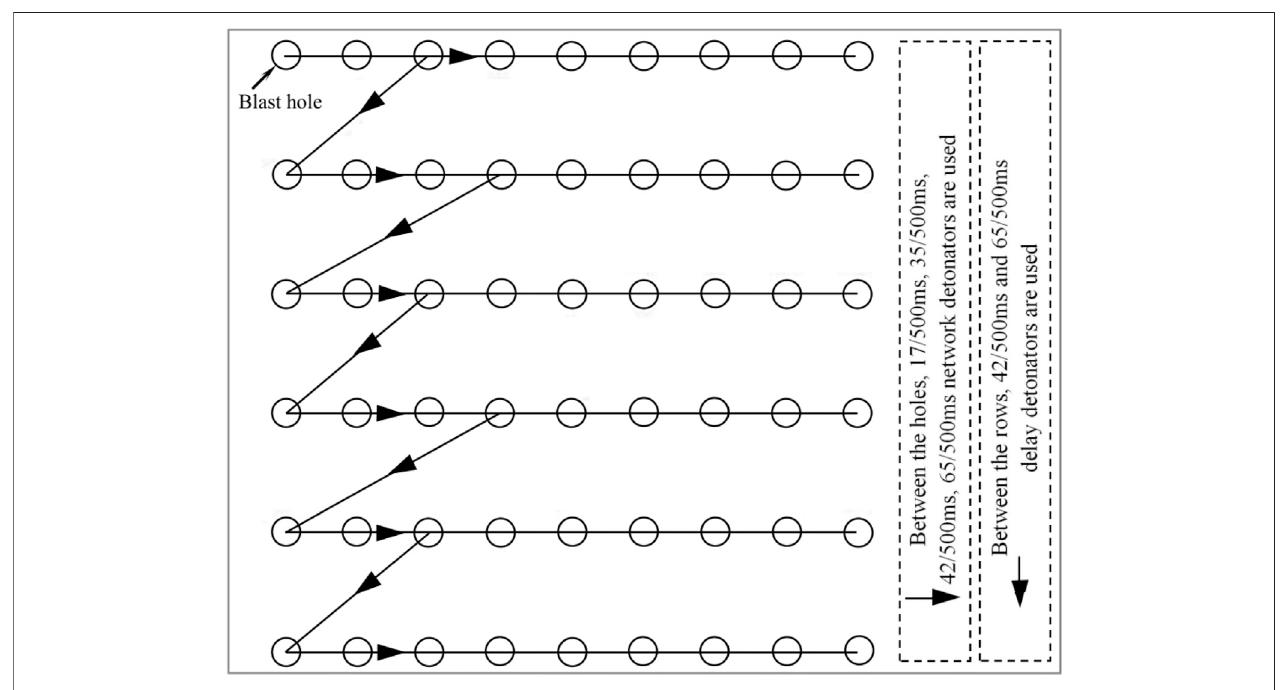
FIGURE 2 | Slash hole-by-hole detonation network diagram.